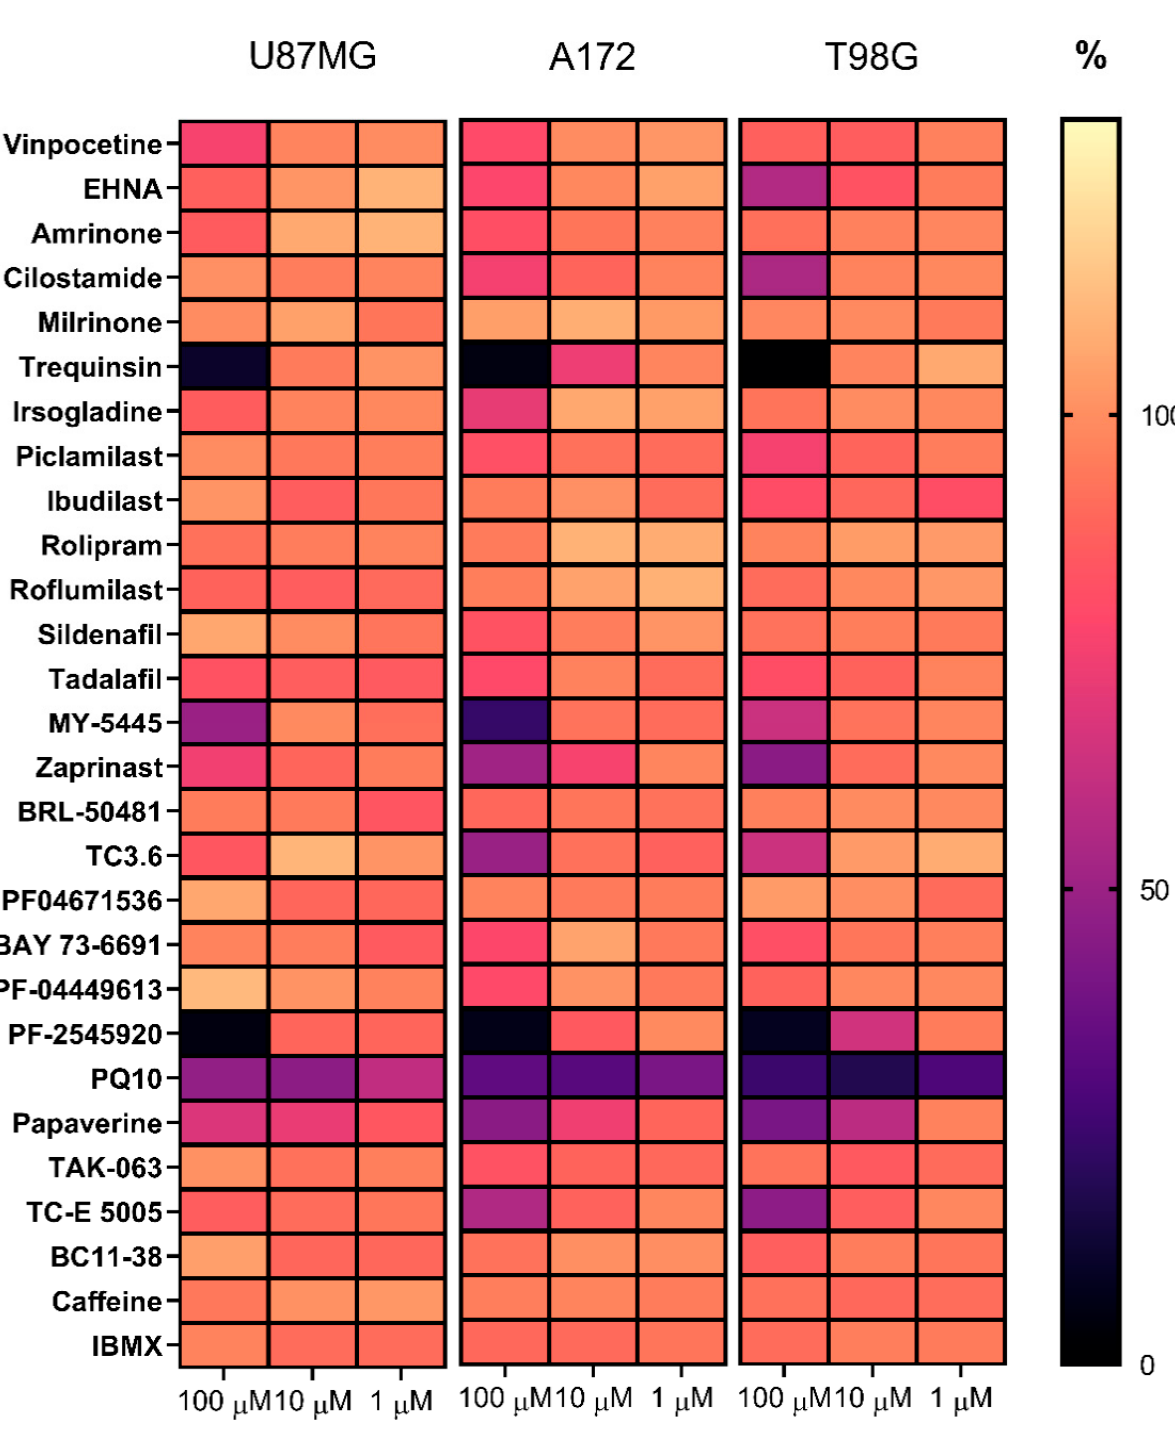
Figure 1. Antiproliferative activity of PDE inhibitors in glioblastoma cells. The heatmap illustrates the percentage of viable U87MG, A172 and T98G cells determined in the CCK-8 assay following treatment with PDE inhibitors at the indicated concentrations for 72 h ( n = 3–12). Detailed quantitative data are presented in Supplementary Table S2.